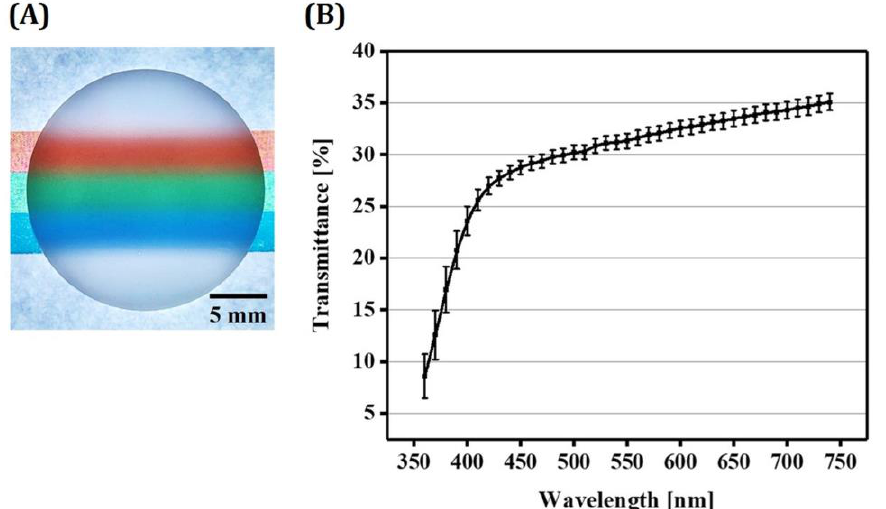
Figure 15. ( A ) Representative optical image of a 5Y-PSZ disk placed on a paper with colored lines and ( B ) spectral transmittance curve for sintered 5Y-PSZ disks.